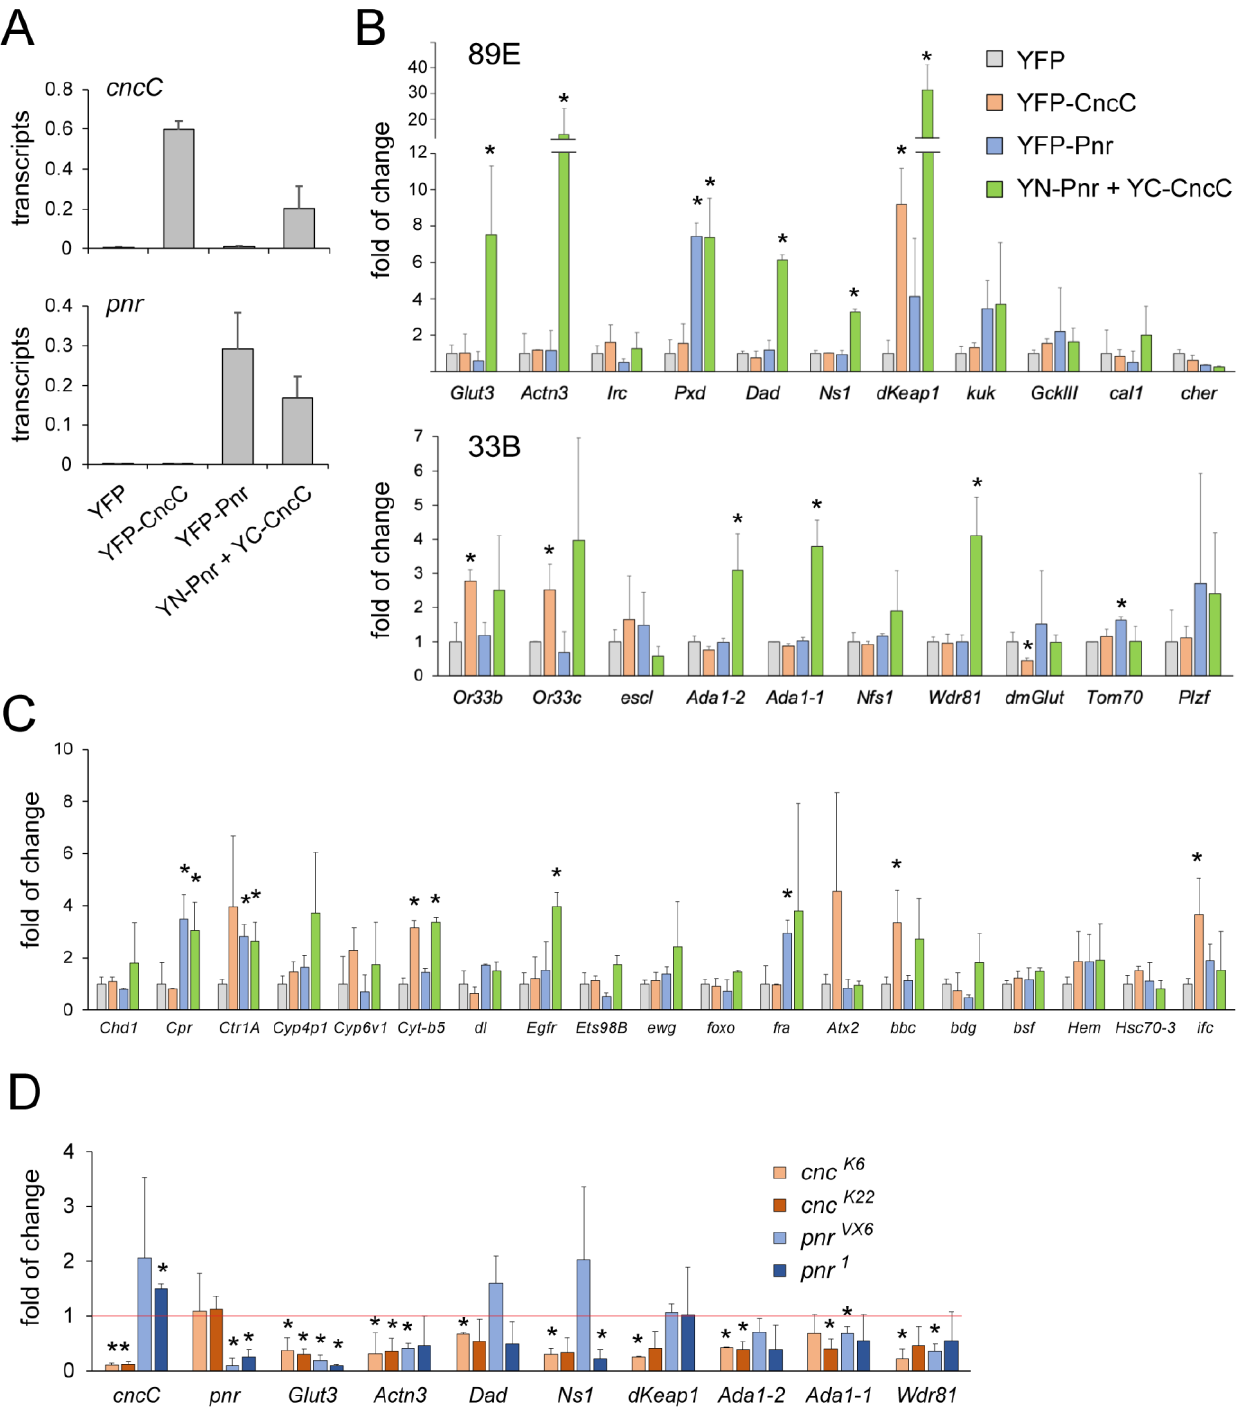
Figure 3. Co-regulation of transcription by CncC and Pnr: ( A ) Expression levels of CncC and Pnr fusions. The levels of cncC and pnr transcripts in salivary glands that expressed YFP (control), YFP – CncC, YFP – Pnr, or CncC – Pnr BiFC fusions using Sgs3-GAL4 were measured by RT-qPCR. Transcript levels were normalized by the levels of Rp49 transcripts. The data show the mean and standard deviation of results from three separate experiments. ( B ) Effects of ectopic CncC, Pnr, and CncC – Pnr BiFC on transcription of genes at loci that are highly bound by CncC – Pnr BiFC complexes. Transcript levels of genes (listed below) at the 89E and 33B loci in salivary glands that that expressed YFP (control), YFP – CncC, YFP – Pnr, or CncC – Pnr BiFC fusions using Sgs3-GAL4 were measured by RT-qPCR. All transcript levels were normalized by the levels of Rp49 transcripts. To facilitate comparison, the transcript levels in cells expressing ectopic fusion proteins were normalized to the levels of